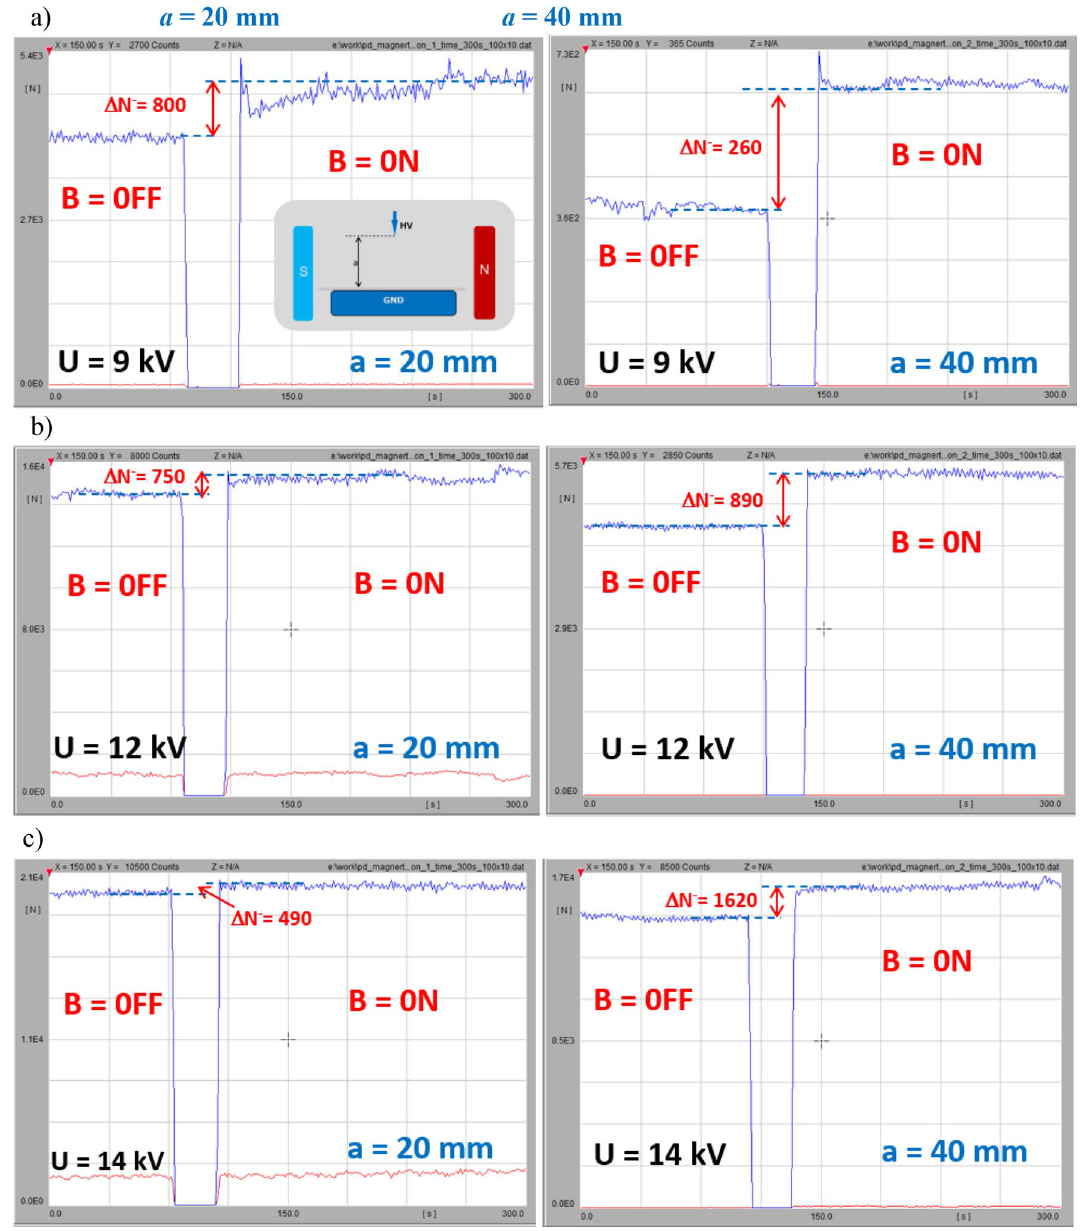
Figure 15. Time sequence B = off/B = on ( B —magnetic induction) of influence of magnetic field on PD intensity ( N —number of discharges) in corona point-plain arrangement for tip-to-ground distances of a = 20 mm (left column) and a = 40 mm (right column) at following voltages: ( a ) 9 kV; ( b ) 12 kV; ( c ) 14